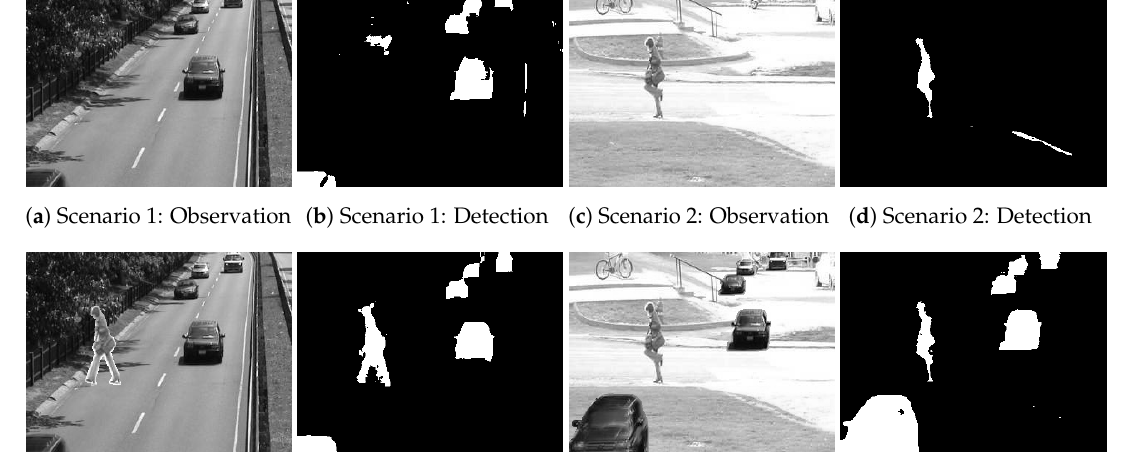
Figure 2. Results from our modified network trained under the four